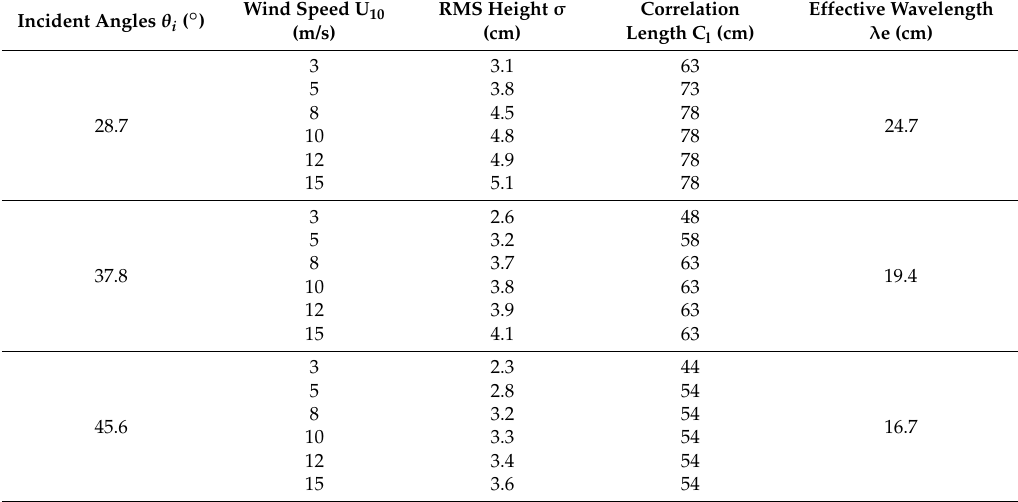
Table 1. The effective roughness parameters corresponding to Figure 5 in the upwind direction (wind direction = 0 ◦ ) at incident angles of 28.7, 37.8, and 45.6 degrees with wind speeds of 3, 5, 8, 10, 12, and 15 m/s.